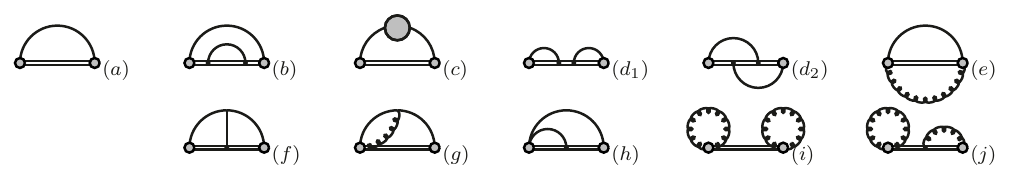
Figure 1 . Diagrams contributing to leading and next-to-leading order to the EQCD force-force correlator Z 3d (3.4). An external gray shaded vertex denotes a D x Φ or F xz insertion; internal g 2-point blobs the respective self-energy; a double line a Wilson line; and a curly line a spatial gauge boson ( A i ). A solid line is a placeholder for either an adjoint scalar ( Φ ) or a spatial gauge boson (otherwise